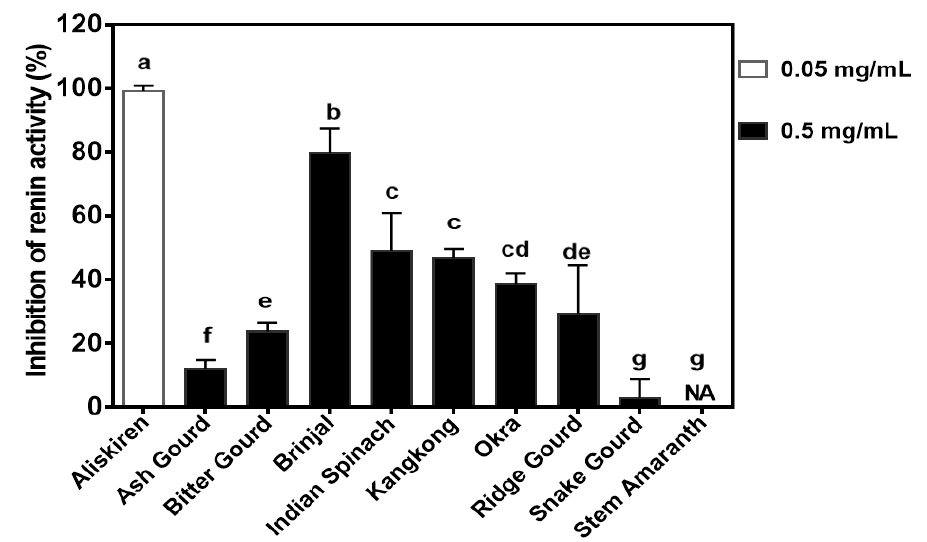
Figure 5. Inhibition of renin activity ( n = 3 ± standard deviation) by aliskiren and aqueous polyphenolic extracts of vegetables. Bars with di ff erent letters have mean values that are significantly ( p < 0.05) di ff